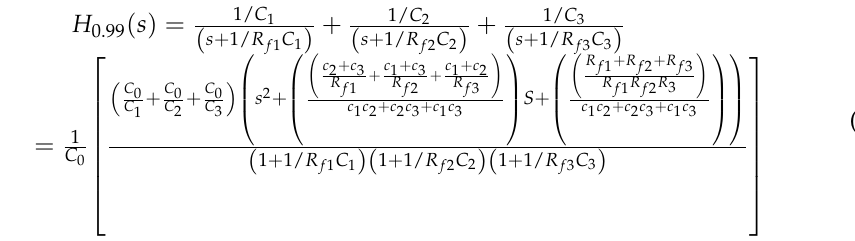
Figure 3. Chain fractance (CF) arrangement of a fractional order ( q = 0.99). Therefore, a transfer function between the chain fractance terminals (A and B), which is illustrated in Figure 3, can be calculated using Equation (13). H 0.99 ( s ) =